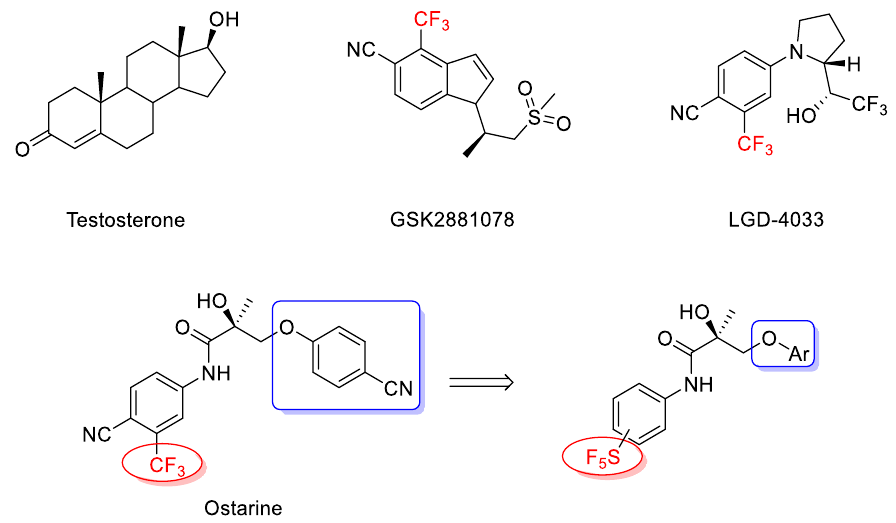
Figure 1. Structures of testosterone and selected SARMs (selective androgen receptor modulators).